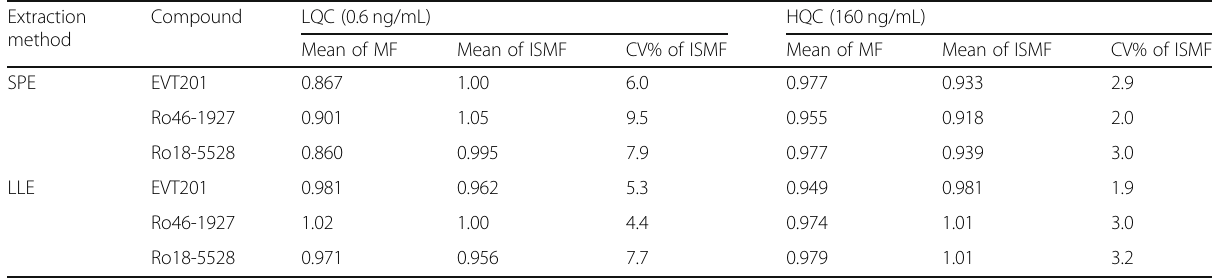
Table 2 Comparison of matrix effect for EVT201 and its two metabolites in human urine with SPE and LLE Extraction method